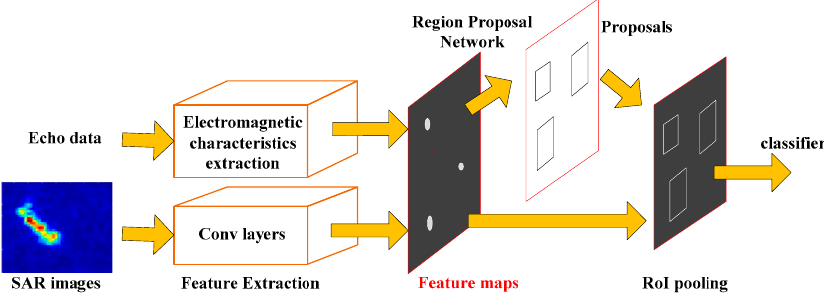
Figure 16. The flowchart of Faster R ‐ CNN ‐ based detector in SAR images.